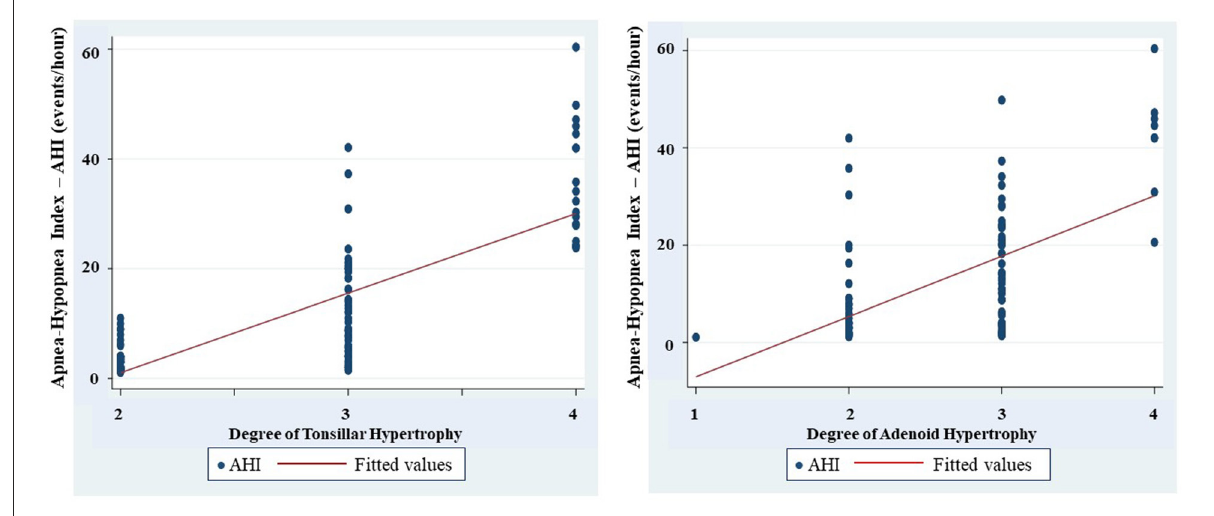
FIGURE2 Correlation between degree of tonsilar and adenoid hypertrophy and apnea-hypopnea index (AHI).